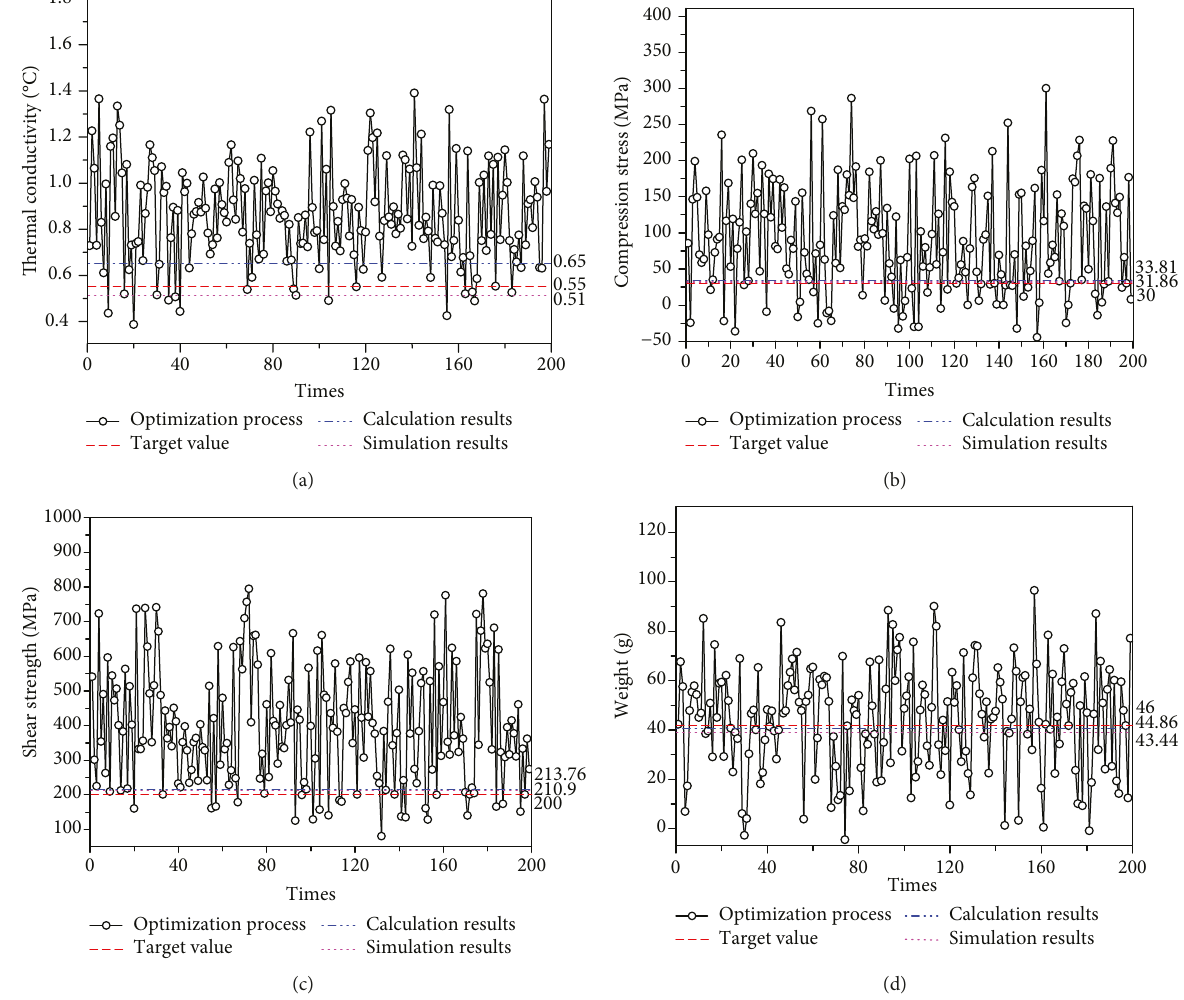
Figure 9: Optimization process, optimization results, and calculation results for (a) temperature di ff erence, (b) compression strength, (c) shear strength, and (d) weight. Table 10: Optimization and fi nal structure parameters of the new type of solar panel.